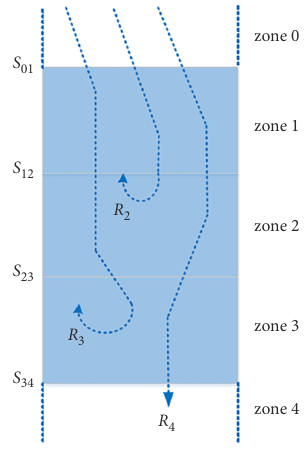
Figure 7. Surveillance area of the VTS